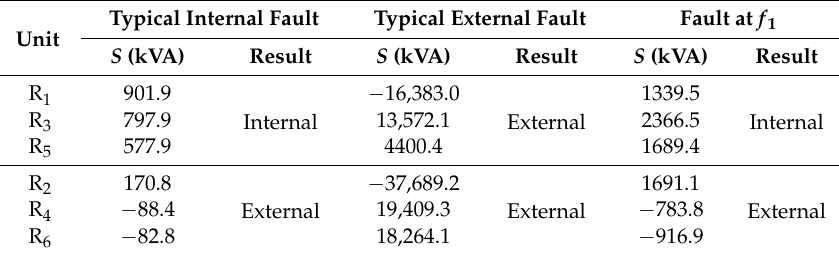
Table 10. Simulation results for a phase B fault on l 3 .